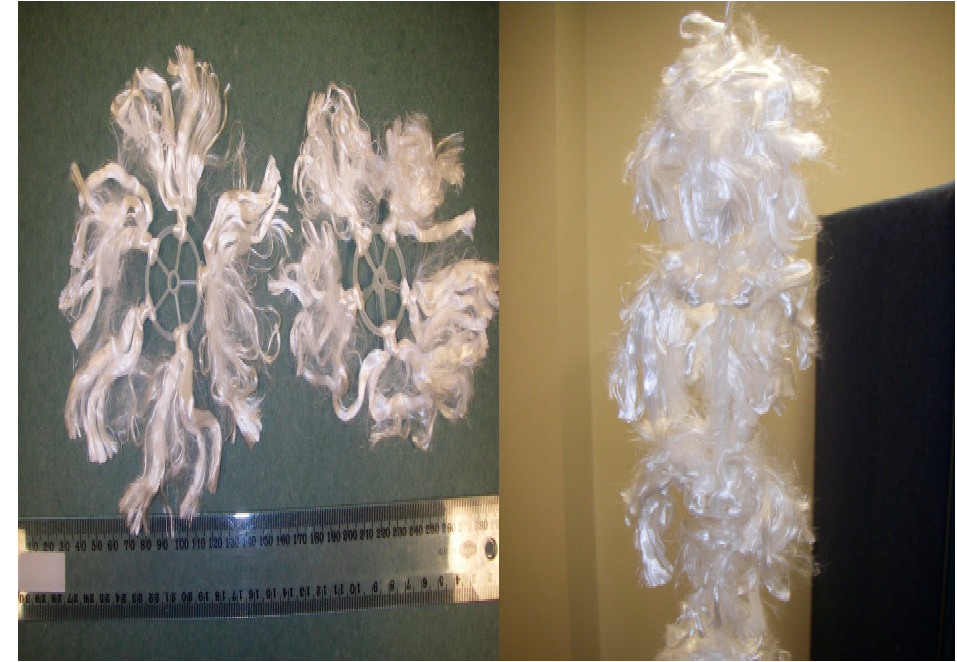
Figure 1. Schematic of SS-FFBR set-up used in this study.